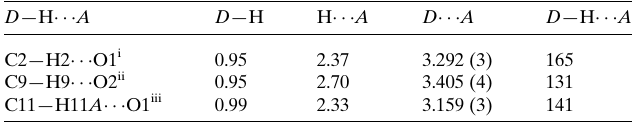
Table 1 Hydrogen-bond geometry (A˚ , (cid:2) ).